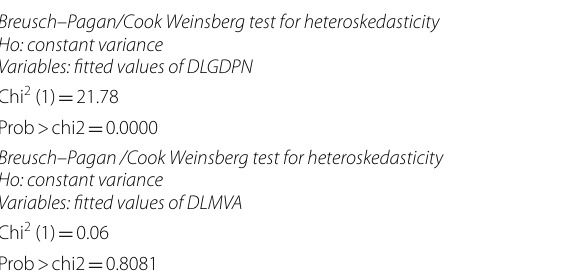
Table 10 Heteroscedasticity test